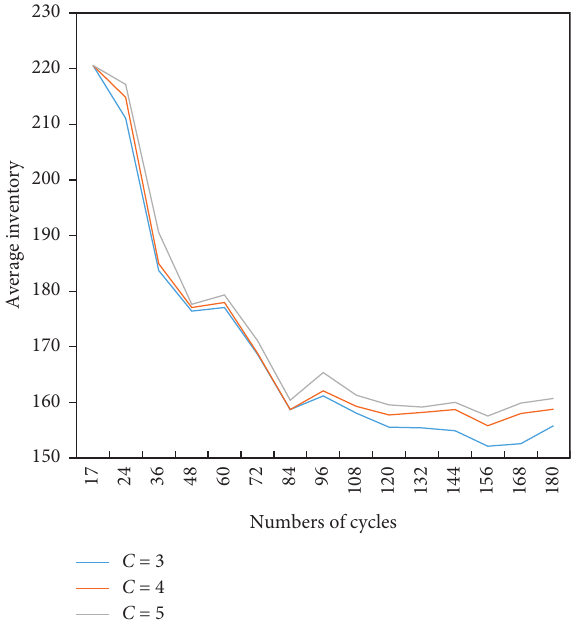
Figure 5: Average inventory in different